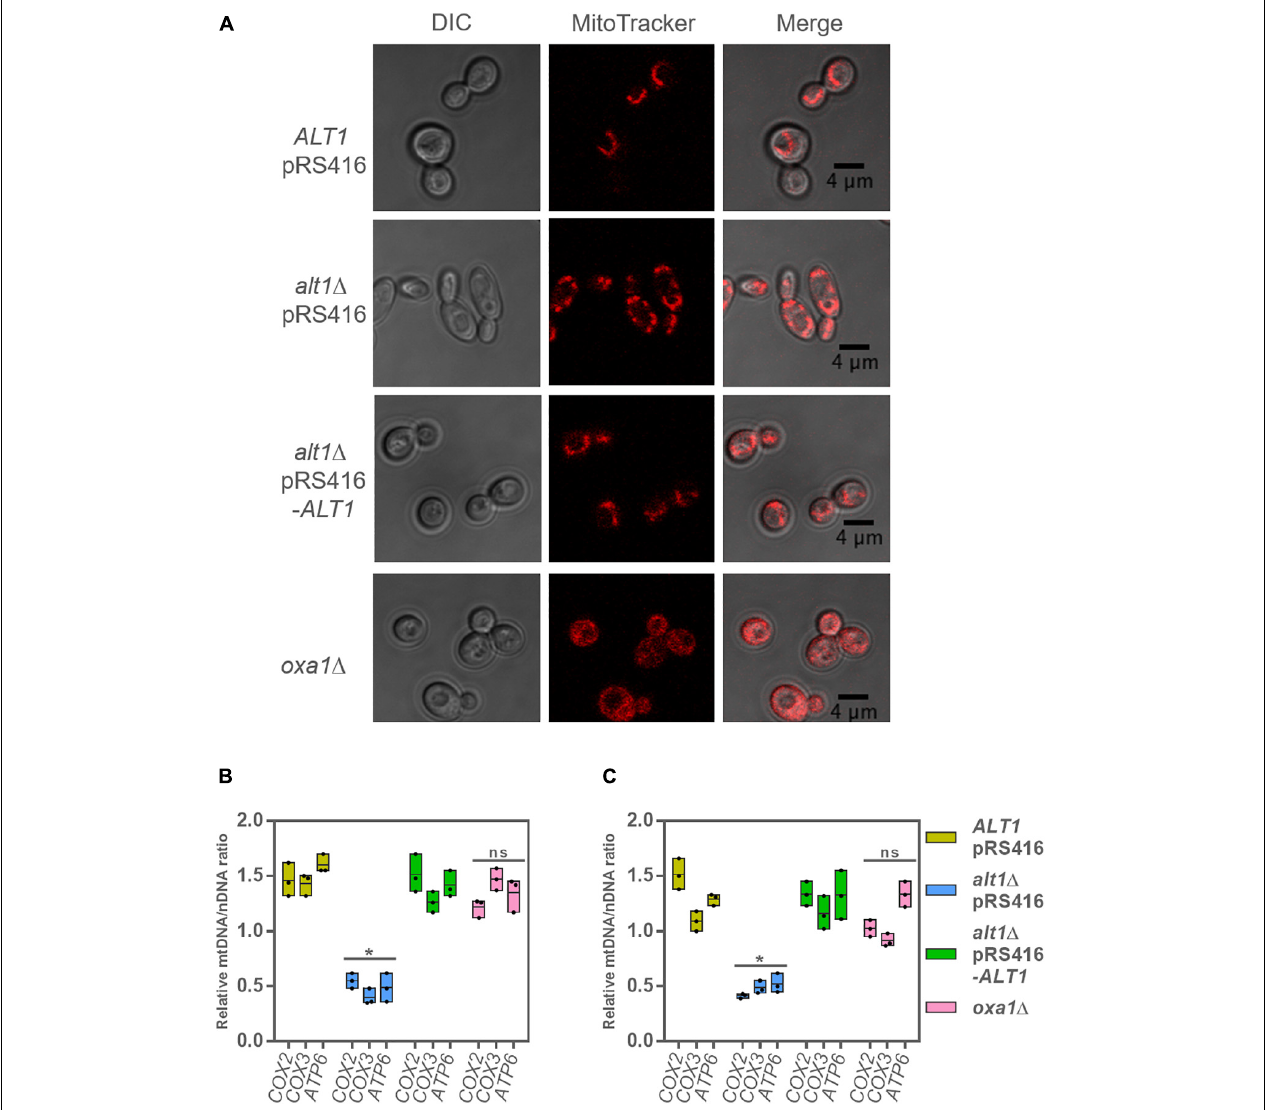
FIGURE 6 | alt1 (cid:49) mutant shows diminished mtDNA vs. nDNA concentration. (A) Mitochondrial staining with MitoTracker CMXRos to determine integrity of mitochondria for indicated strains. Cells were harvested in glucose + GABA and collected at OD 600 nm = 0.6. Estimation of mtDNA/nDNA ratio by qPCR using COX2 , COX3 , and ATP6 as mitochondrial genes; this determination is relative to COX6 encoded nuclear gene in (B) glucose + GABA and (C) glucose + ammonium. Boxes show individual values (points) and the average (middle line) ± SE of three independent experiments. Asterisk indicate significant differences *P < 0.05, t- test (Student). Abbreviation: ns, not